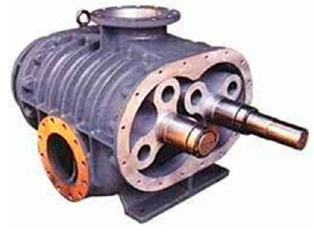
Figure 4. Roots blower